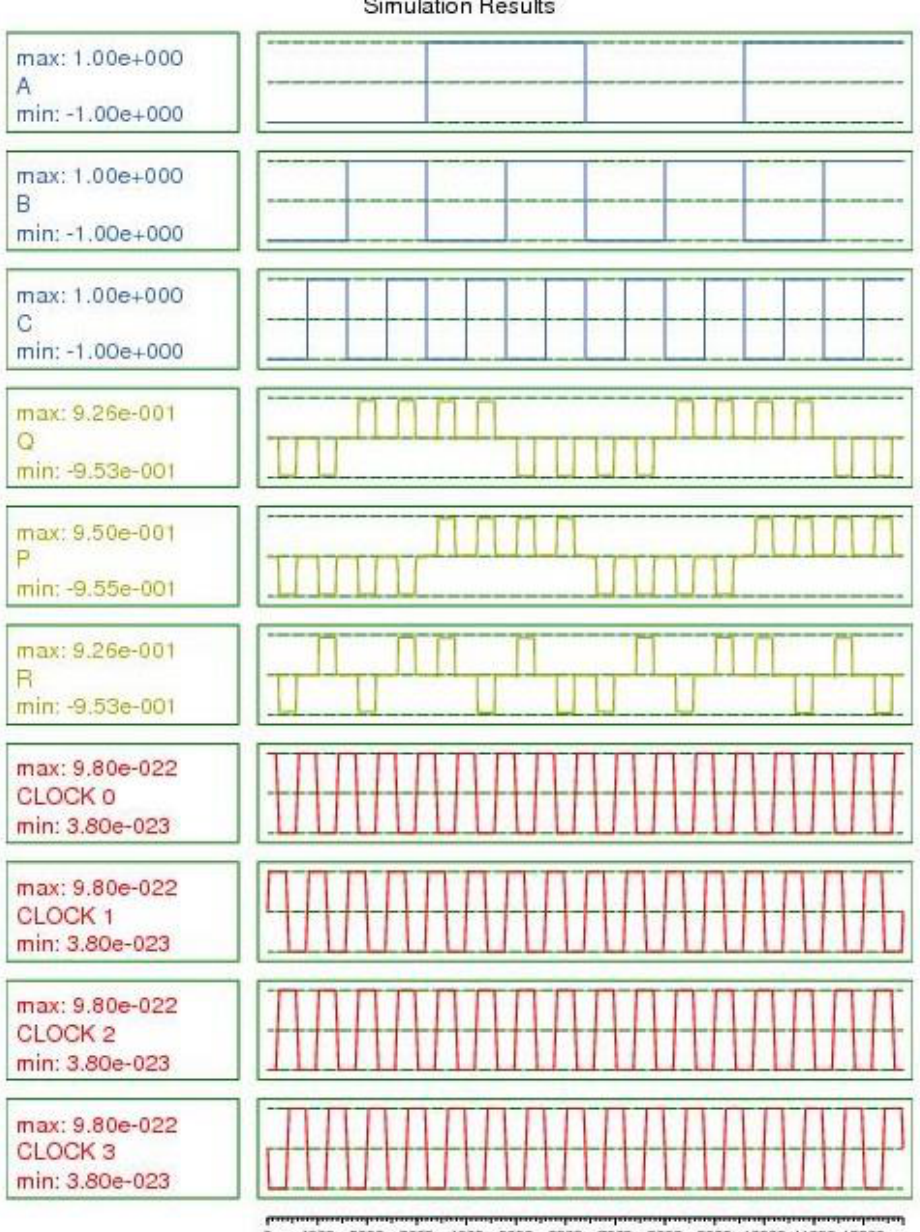
Figure 6. The proposed 3 × 3 reversible circuit simulation results.